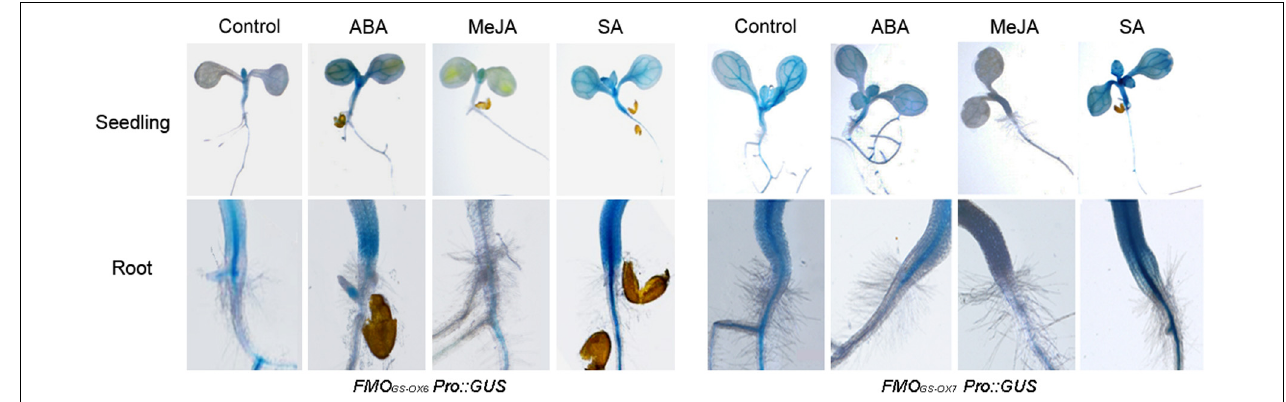
FIGURE 3 | Expression of FMO GS - OX 6 and FMO GS - OX 7 in response to exogenous abscisic acid (ABA), methyl jasmonate (MeJA), and salicylic acid